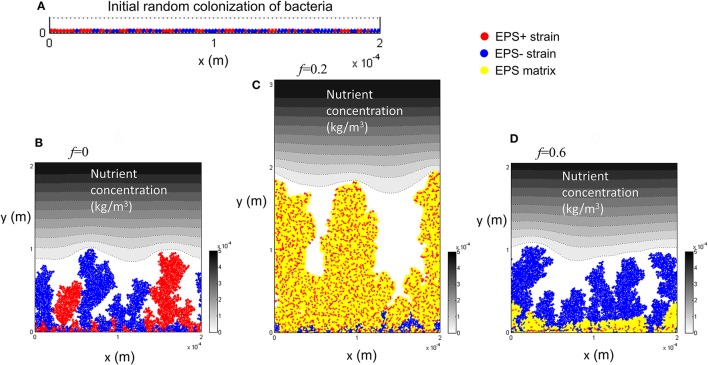
Competition between EPS+ and EPS− strains when both strains are initially randomly inoculated on the substratum: (A) initial inoculation of bacteria; (B) biofilm after 12 days at f = 0; (C) biofilm after 12 days at f = 0.2; (D) biofilm after 12 days at f = 0.6. It is seen that both strains co-exist in the biofilm if there is no EPS production, EPS+ strain dominates at f = 0.2 and EPS− strain dominates at f = 0.6. The contour plot shows the nutrient level from low to high as white to black. All values are in SI units.